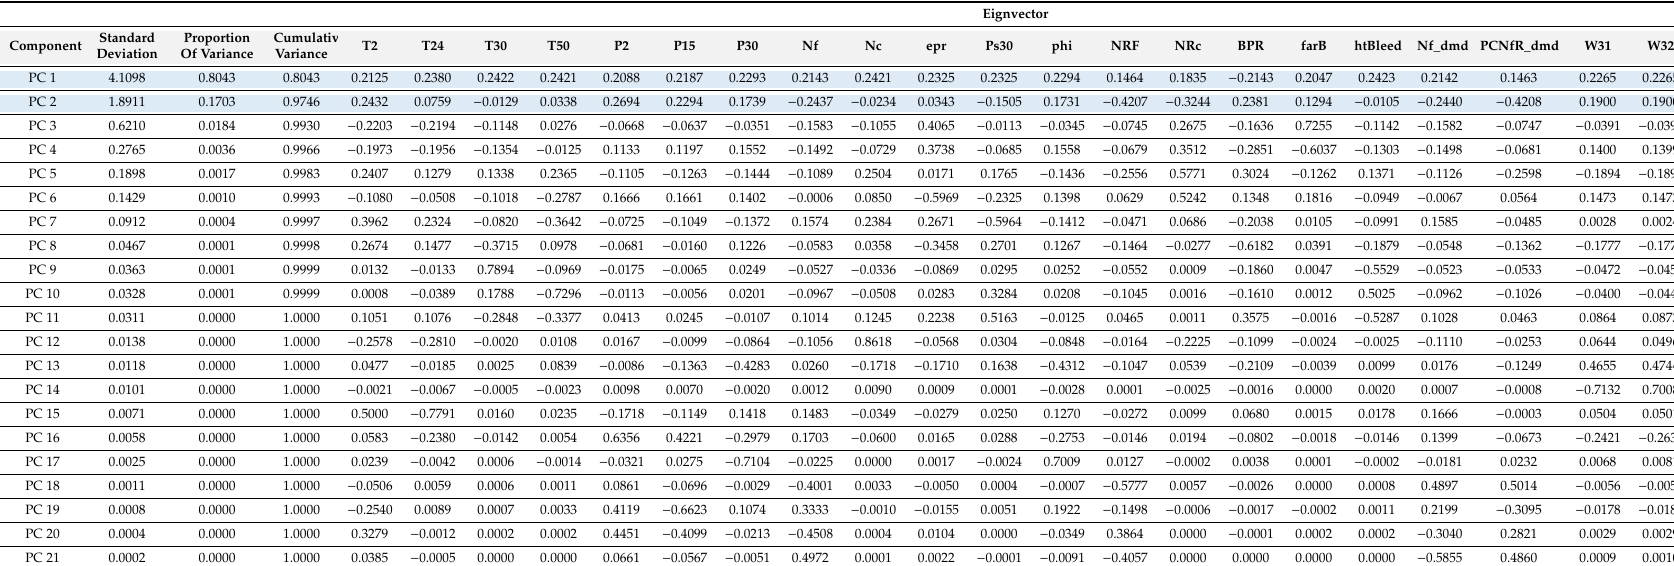
Table A2. Principle Components (PC)